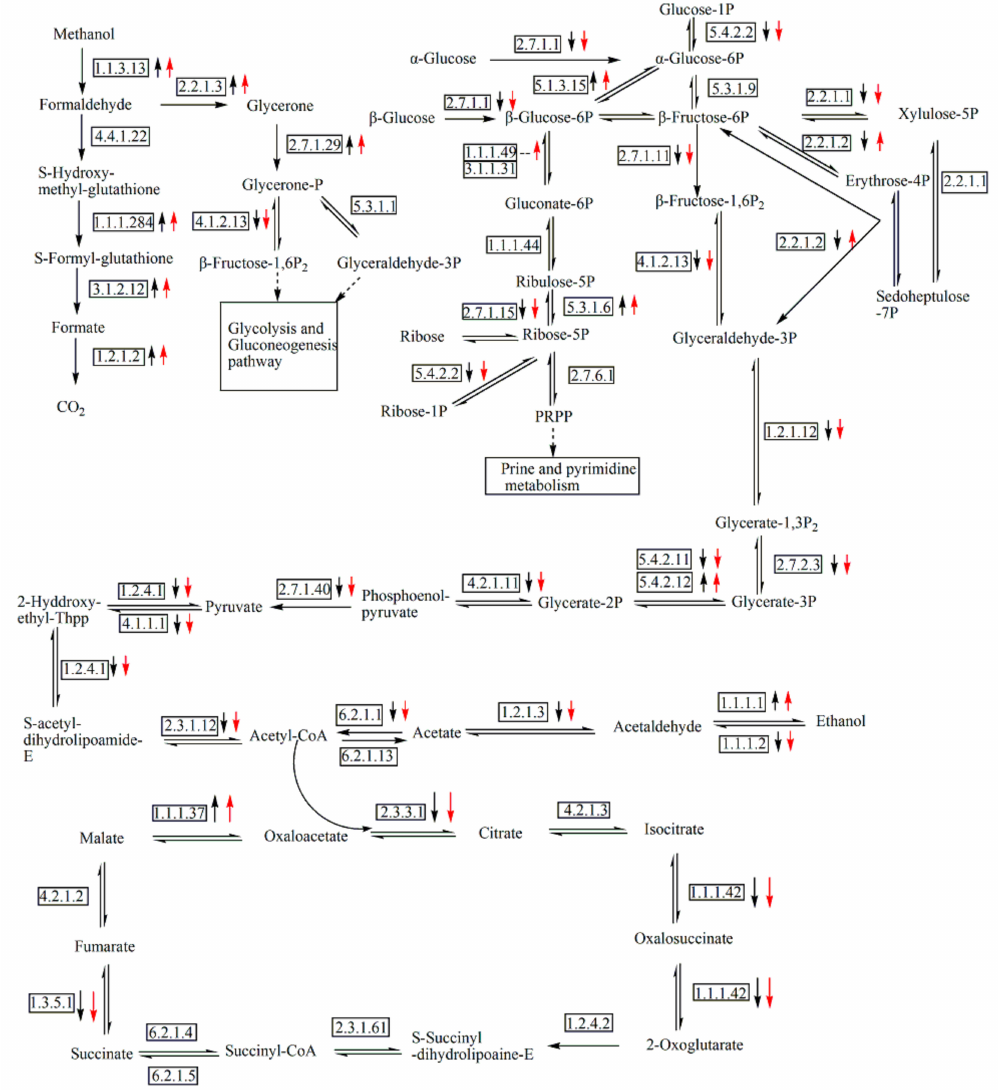
Figure 2. Overview of DEGs involved in central carbon metabolic pathway in PI1 and PI2 in comparison to BI. Up-regulated or down-regulated genes ( p adj < 0.01) are depicted with up or down arrow (black arrow stands for PI1, red arrow indicates PI2), respectively. A dash line indicates no significant change in comparison to